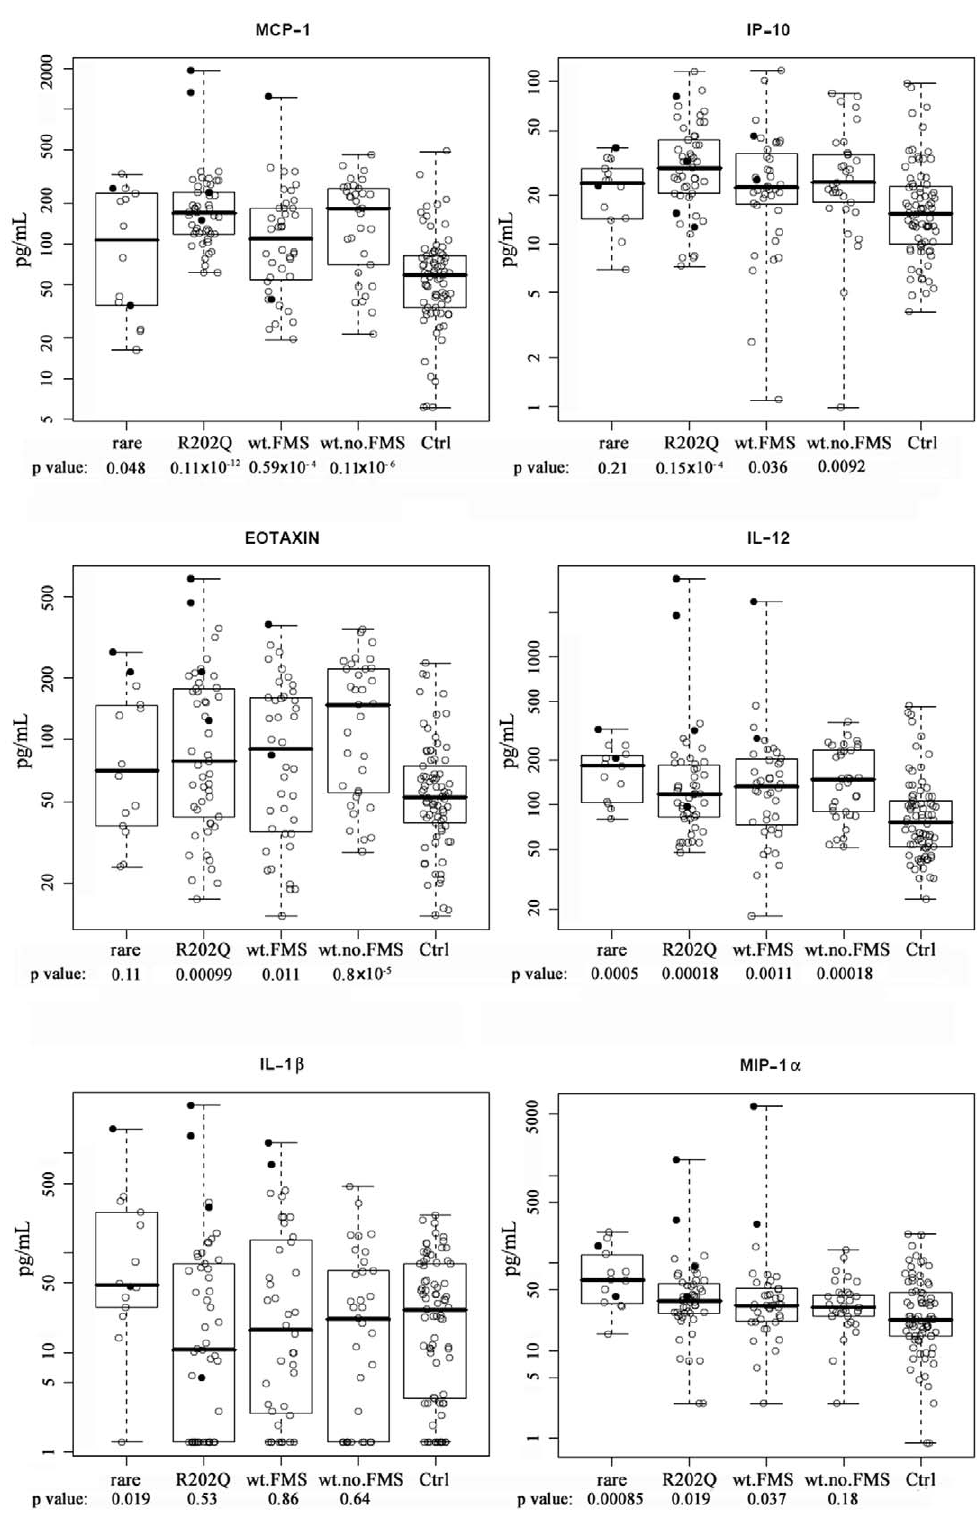
Figure 2. Plasma chemokine/cytokine levels by MEFV genotypes in FMS patients and family members, and in unrelated controls. Ctrl: plasma levels (pg/mL) for unrelated controls (n=77) of unknown genotype. Wt no FMS: unaffected parents without variant alleles (n=35). Wt FMS: FMS probands (n=37) with wild type (non-variant) MEFV gene. R202Q: FMS probands and family members with R202Q genotype (n=49). Rare: FMS patients with a rare variant of the MEFV gene (n=14). P values are shown below each group. Boxplots indicate the median (heavy bar), central 50% of data (box) and range of observations (whiskers). P-values are from two-sided t-tests contrasting each group with the control group, using pooled variance, a logarithmic scale, and without any adjustment for multiple comparisons. In addition, subjects with the rare MEFV alleles compared to wt FMS patients had elevated levels of MIP-1 a (p=0.019); subjects with R202Q polymorphism compared to wt FMS patients had elevated levels of MCP-1 (p=0.004).